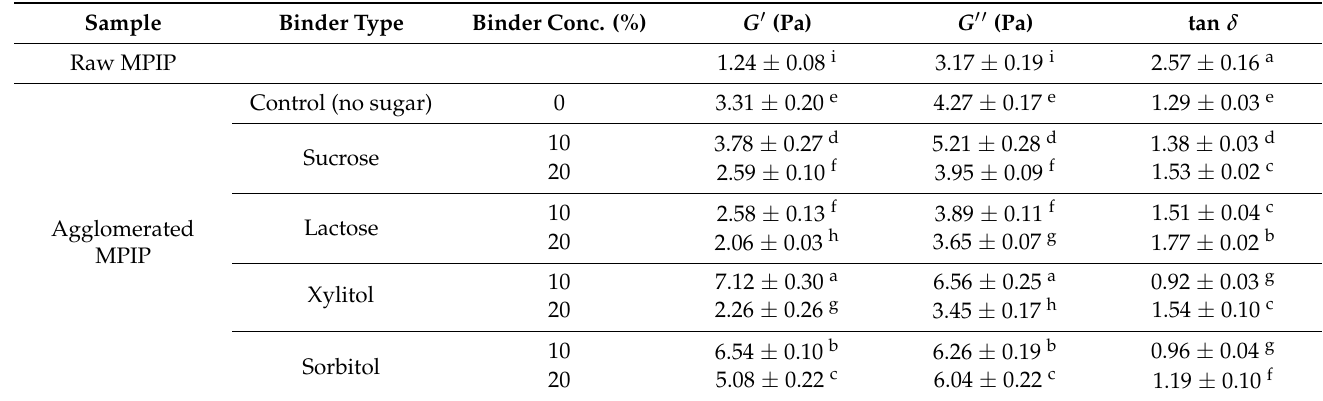
Table 5. Values of dynamic rheological parameters at 6.28 rad · s − 1 of raw and agglomerated MPIPs prepared with various sugar binders at different